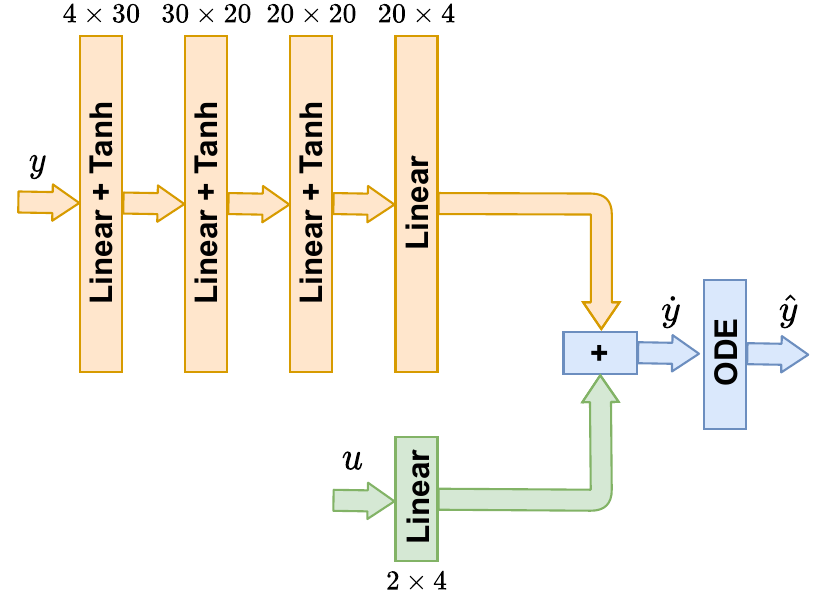
Figure 5. Neural network model for ODE